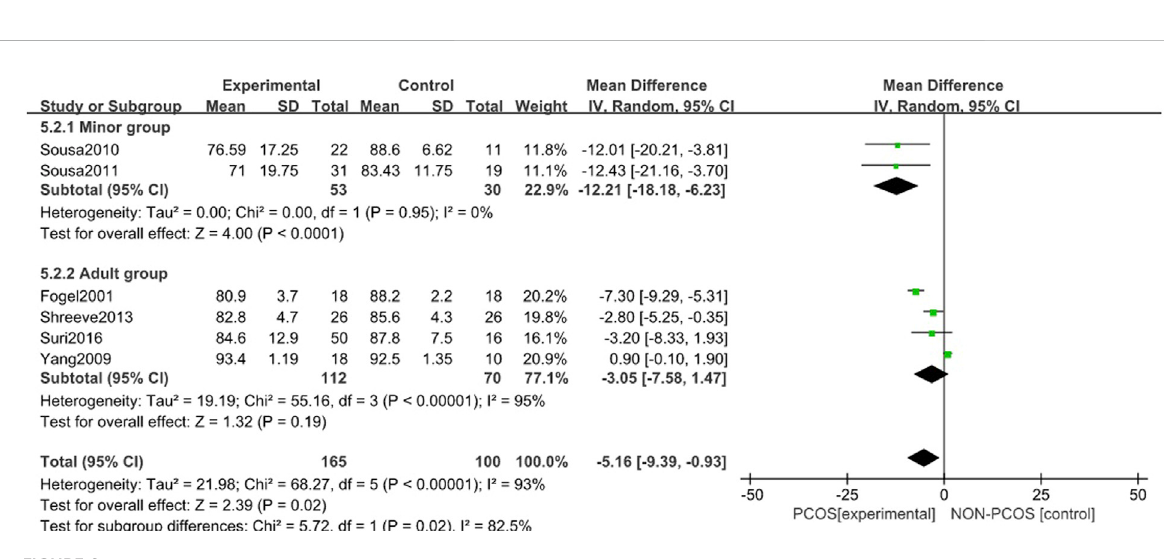
group (MD = -5.16, 95% CI: 9.39 – -0.93, Z = 2.39, p = 0.02), which was statistically signi fi cant, but the included studies were heterogeneous. To further verify the relationship between